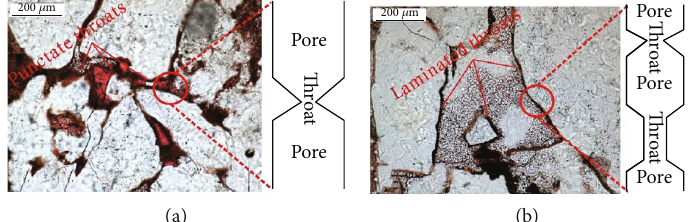
Figure 11: Optical observation and pore-throat combination: (a) monofractal throat distribution specimen (from type R1, S26); (b) bifractal throat distribution specimen (from type R4,